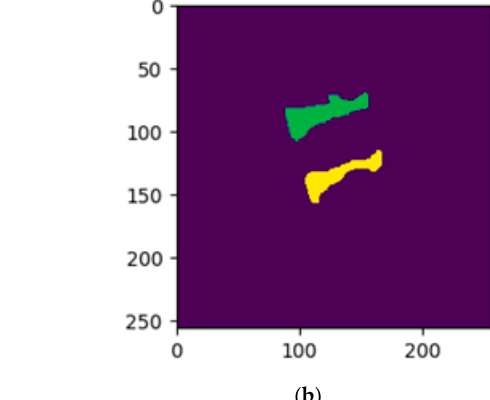
Figure 4. The cropped images that were used to train the MultiResUNet in the first stage: ( a ) the cropped original spine MRI image (shown in the viridis color maps); ( b ) the corresponding standard masks of the lower two intervertebral discs of ( a ).